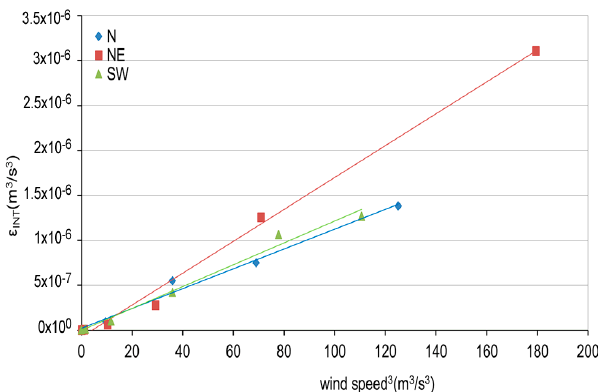
Figure 14. The integrated dissipation of turbulent kinetic energy through the vertical profile in the point of the marina centroid versus the cube of the wind speed for the N, NE and SW wind direction. The goal of the model calibration was to obtain the best similarity between the integrated discharge measured by PCM and modelled through one culvert pipe. Figure 15 shows the results of the measured and modelled integrated discharge through one culvert pipe.